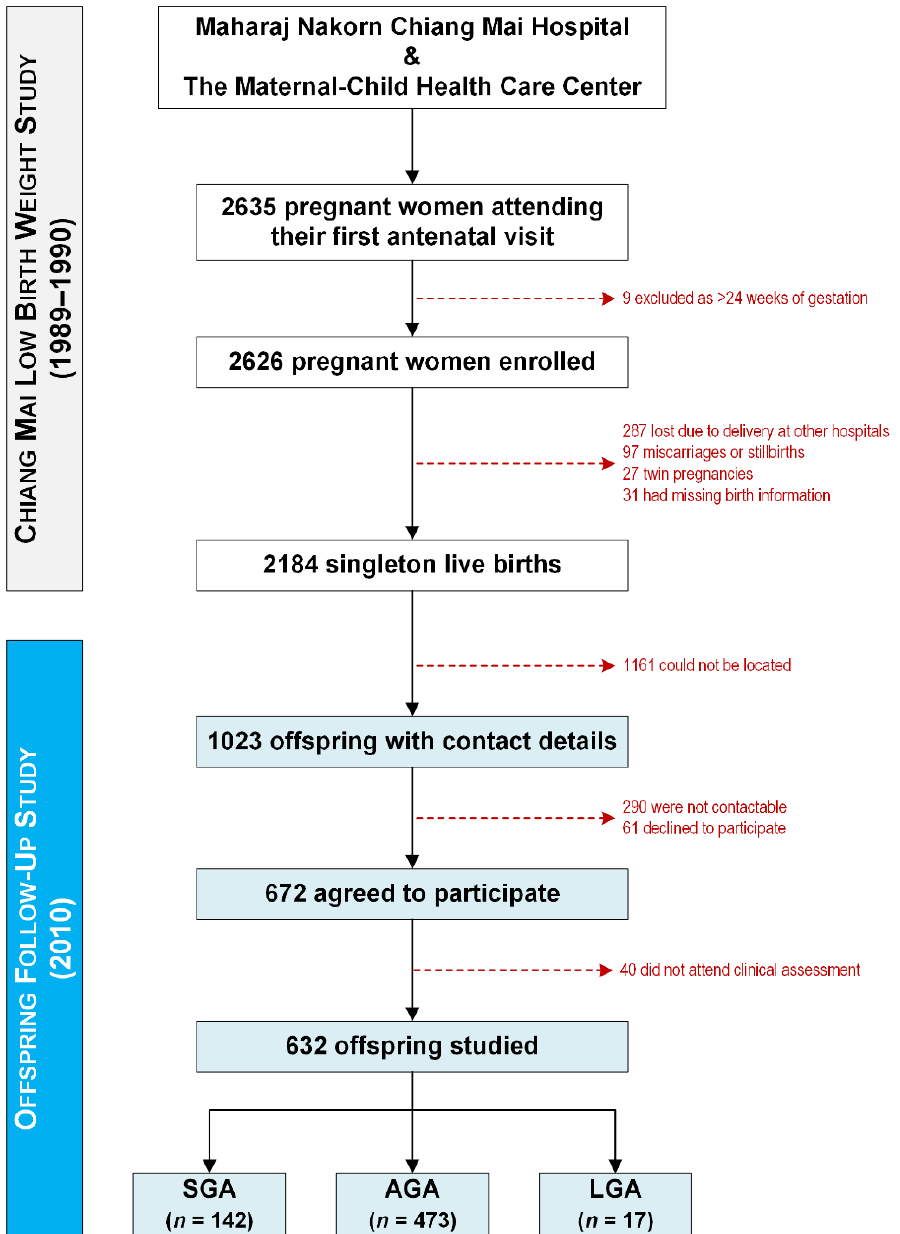
Figure 1. The recruitment of participants to the original Chiang Mai Low Birth Weight Study (1989 – 1990) and later on to the follow - up study on the offspring (2010) . Table 1. Demographic and birth characteristics of our study population stratified by birth weight status . Characteristic